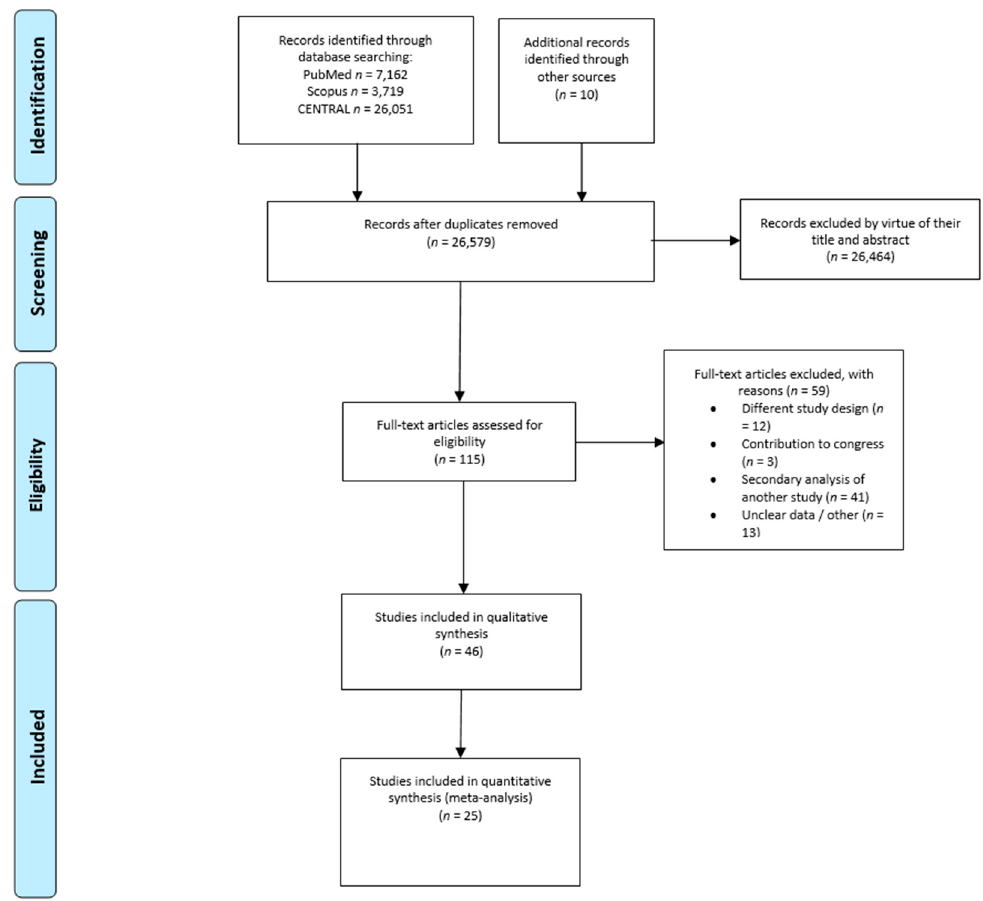
Figure 1. Preferred Reporting Items for Systematic Reviews and Meta-Analysis (PRISMA) flow diagram of